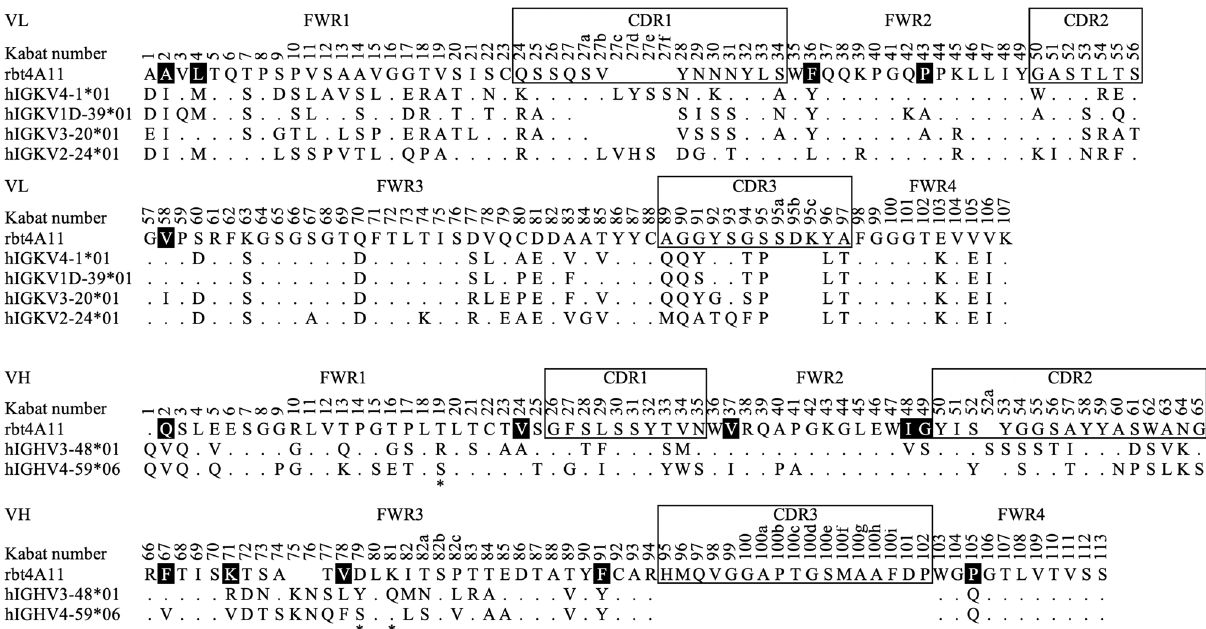
Figure 1. Amino acid sequence alignment of VL and VH of rbt4A11 with the closest human germline acceptor frameworks for humanization. The variable light chain (VL) and heavy chain (VH) domain of rbt4A11 was aligned with its closets human germlines to specify the different (letter) and identical (dot) amino acid residues in framework regions (FWR) and complementarity-determining regions (CDRs) by Kabat numbering scheme 6 . Six CDRs (box) and fifteen framework residues at Vernier zone (black fill) of rbt4A11 were fused in-frame to individual human germline acceptor framework for shuffling. Three positions (19, 79, 81) at the heavy chain framework guided by structure complex analysis were residues used to modulate antibody function (asterisk). The positions with sequence deletion and undefined heavy chain germline CDR3 were shown in